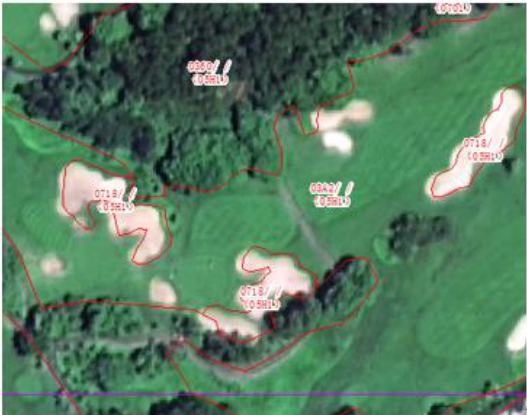
Figure 7. referring to Digital Orthophoto Image, the sandy surface is incorrectly collected as a structure